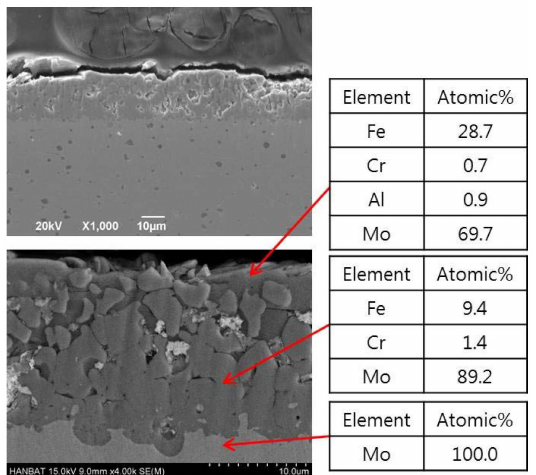
Figure 5. Cross-sectional microstructure of the post-laser-treated TZM alloy that was isothermally heated at 1100 ˝ C.